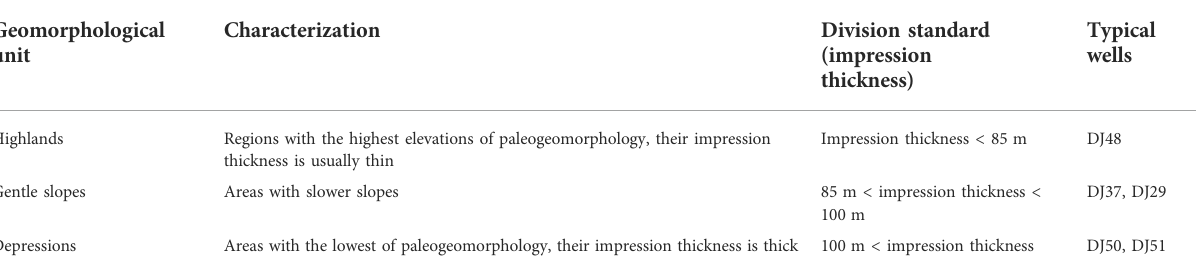
TABLE 1 The characteristics of the paleogeomorphological units and the division standard in the early deposition stage of Shan-2 Lower Sub- member. Geomorphological